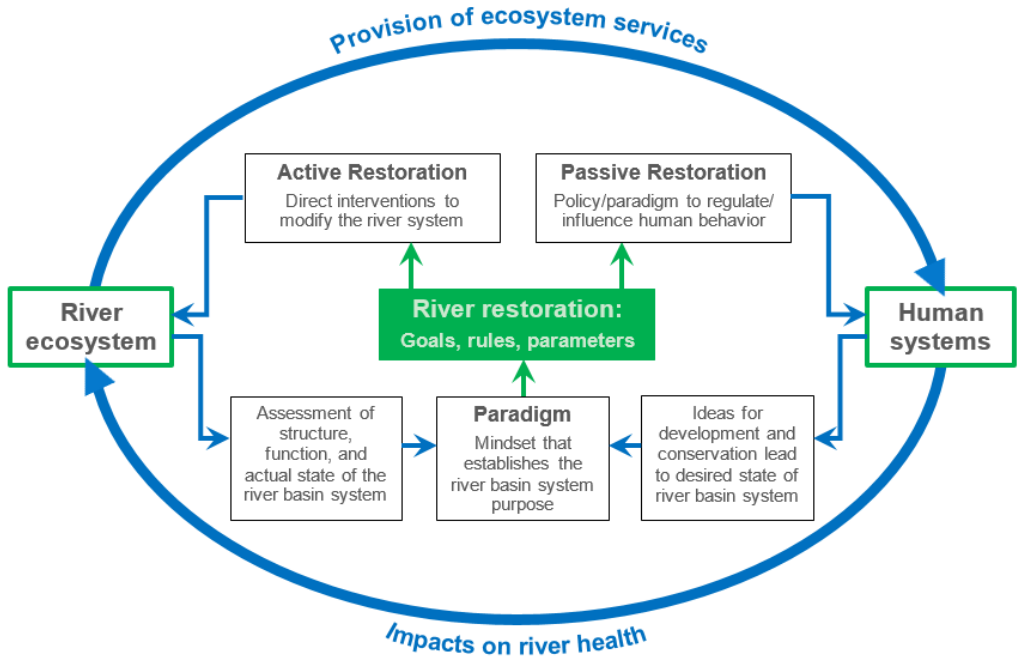
Figure 1. Conceptual model of a river basin system with human systems benefiting from and affecting the ecosystems, and the formulation of a paradigm for river basin restoration based on comparing actual vs. the desired state of the system. Adapted from Speed et al. [1].